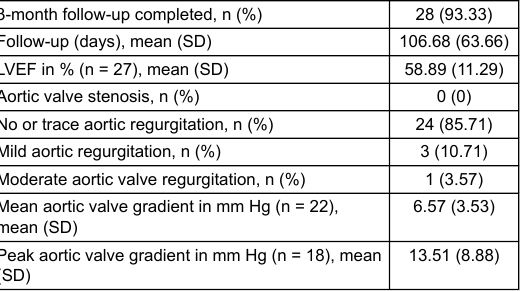
Table 6: Echocardiographic characteristics after 3 months (n =